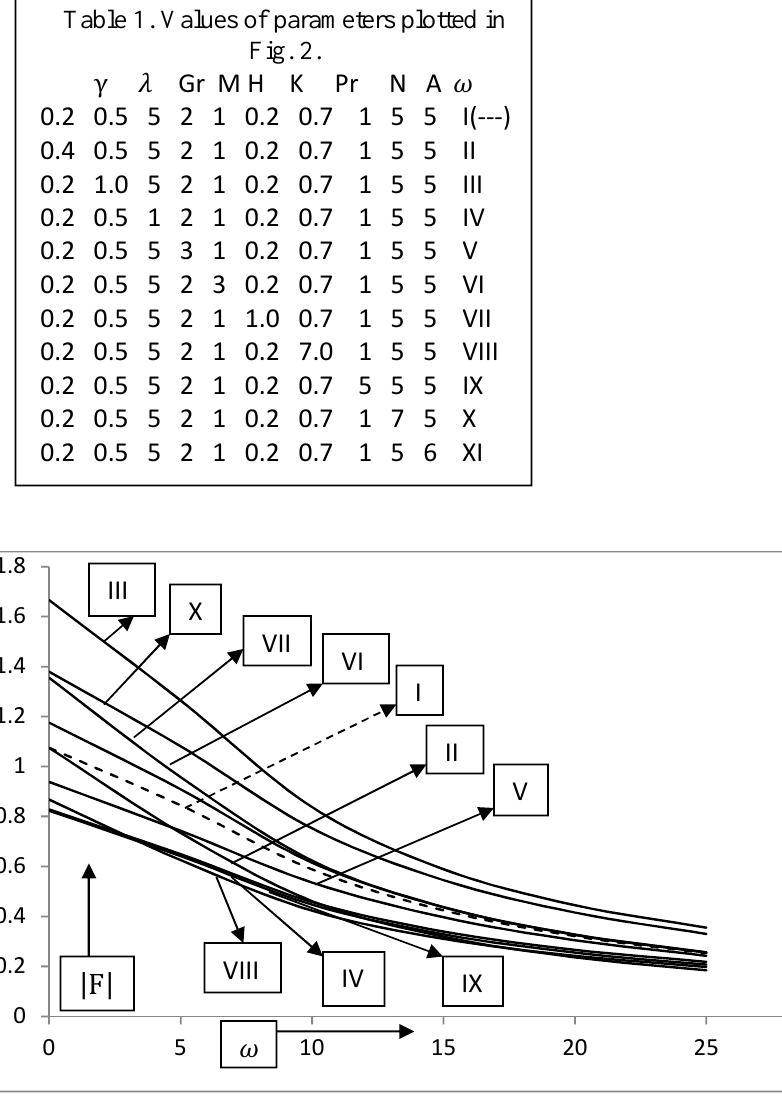
Fig. 3a. Amplitude of skin friction.